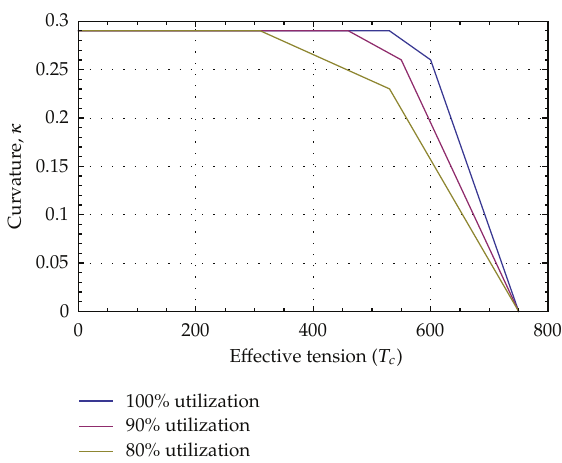
Figure 11: Example of umbilical capacity